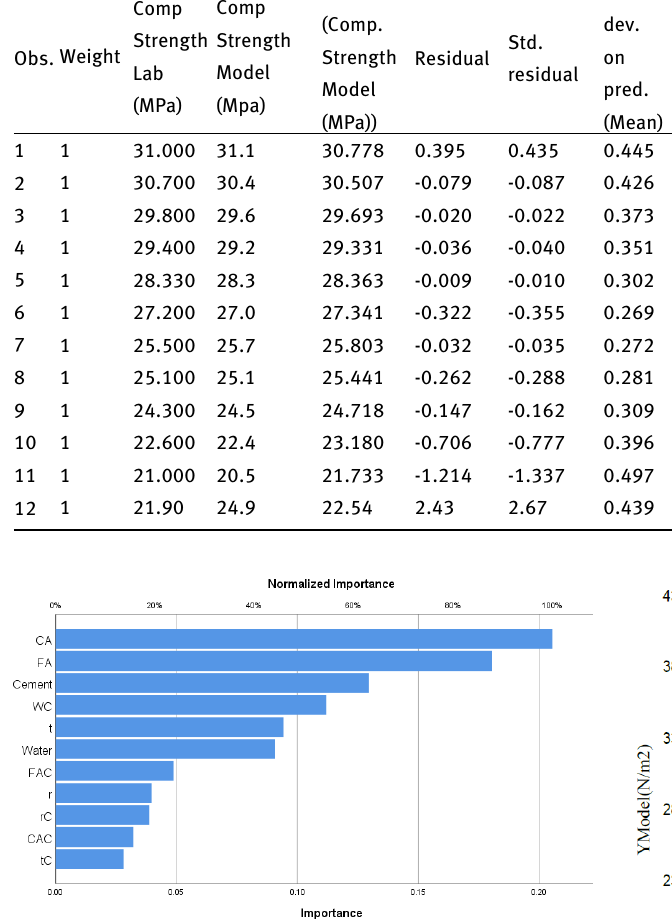
Figure 8: Importance of Independent Variables